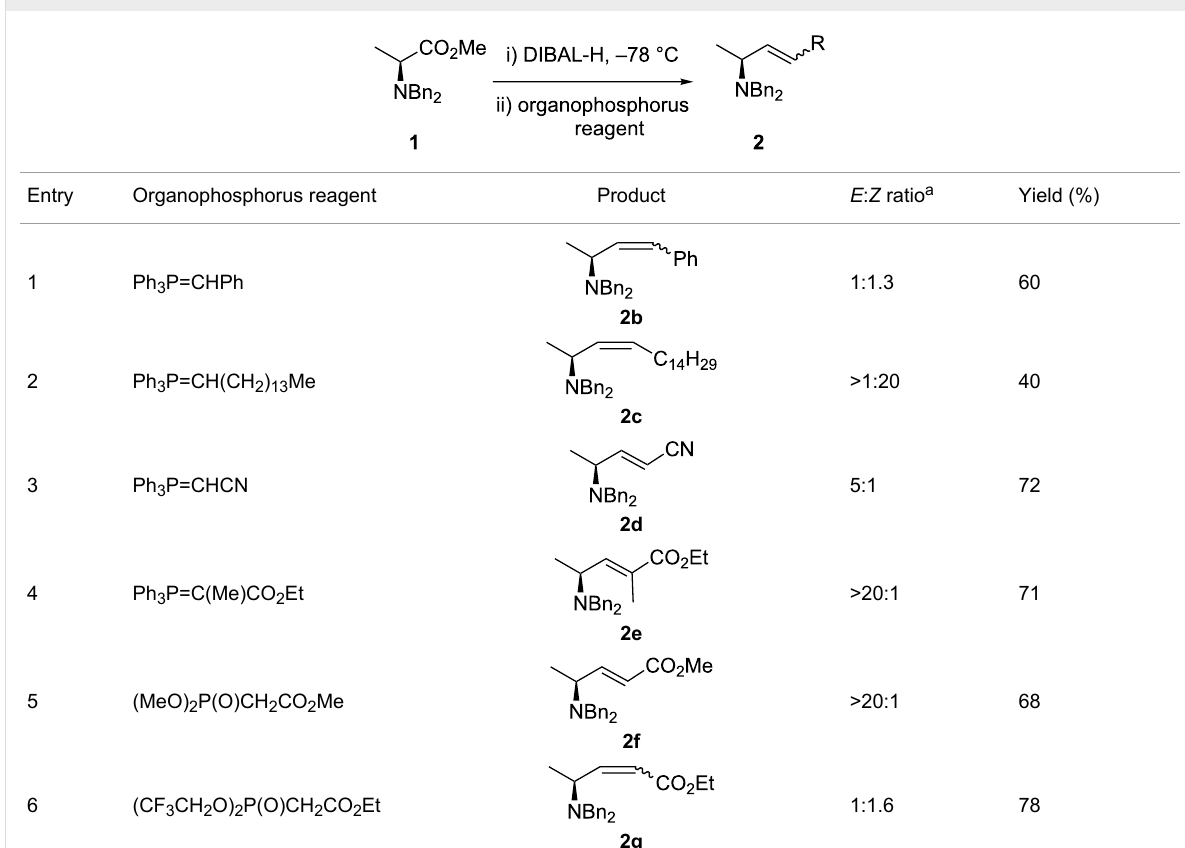
Table 2: Influence of the organophosphorus reagent in the outcome of the one-pot tandem reduction–olefination.